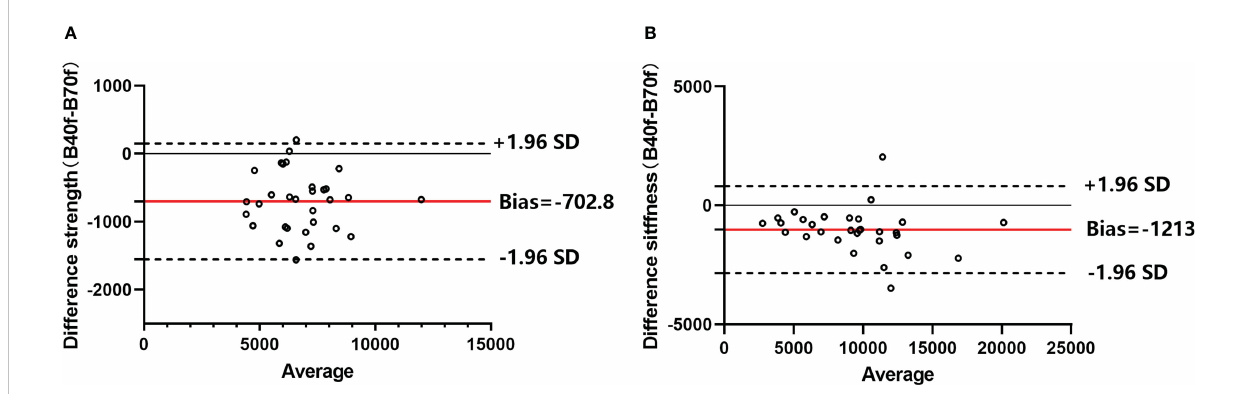
FIGURE 2 Bland – Altman plots of FE-estimated strength (A) and stiffness (B) between smooth standard kernel (B40f) and sharp bone kernel (B70f). Horizontal red lines represent the average difference between the two kernels (B40f – B70f), and the dashed line means a 95% con fi dence